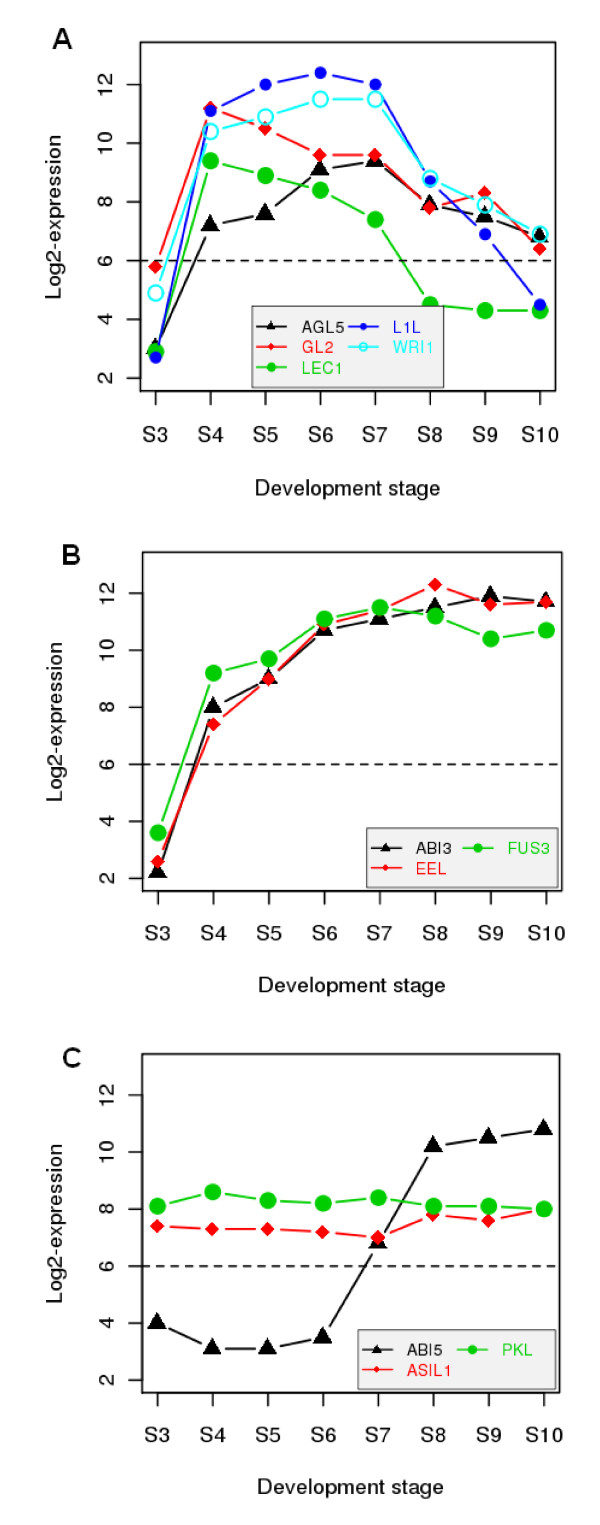
Expression profiles of several well-characterized transcription factor genes. The dashed line at 6.0 on the y-axis is often used as the cutoff for present (expressed; above the line) or absent (unexpressed; below the line). All expression data were transformed to the log2 scale for plotting the profiles. Refer to Additional File 3 for their AGI identifiers and full name of each transcription factor gene. The gene abbreviations are as follows: AGL5: AGAMOUS-LIKE 5; GL2: GLABRA 2; LEC1: LEAFY COTELYDON 1; L1L: LEAFY COTELYDON 1 LIKE; WRI1: WRINKLED 1; ABI3: ABSCISIC ACID-INSENSITIVE 3; EEL: ENHANCED EM (EMBRYO MORPHOGENESIS) LEVEL; FUS3: FUSCA 3; ABI5: ABSCISIC ACID-INSENSITIVE 5; PKL: PICKLE; ASIL1: ARABIDOPSIS 6B-INTERACTING PROTEIN 1-LIKE 1.